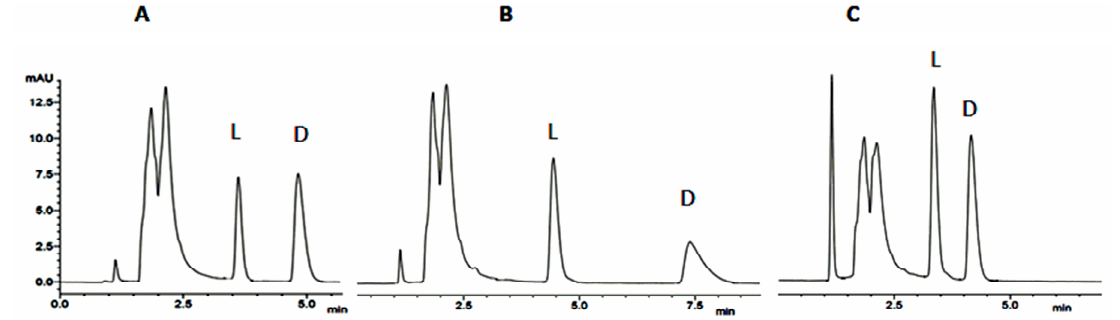
Figure 18. Chromatograms of enantiomeric mixture of DL -Ala ( A ), DL -pipecolic acid ( B ), and DL -Val ( C ). Column, Chirobiotic T; Mobile phase, MeOH:H 2 O:acetic acid (70:30:0.02 v / v / v ); Flow rate, 1.0 mL/min; UV detection, 210 nm.